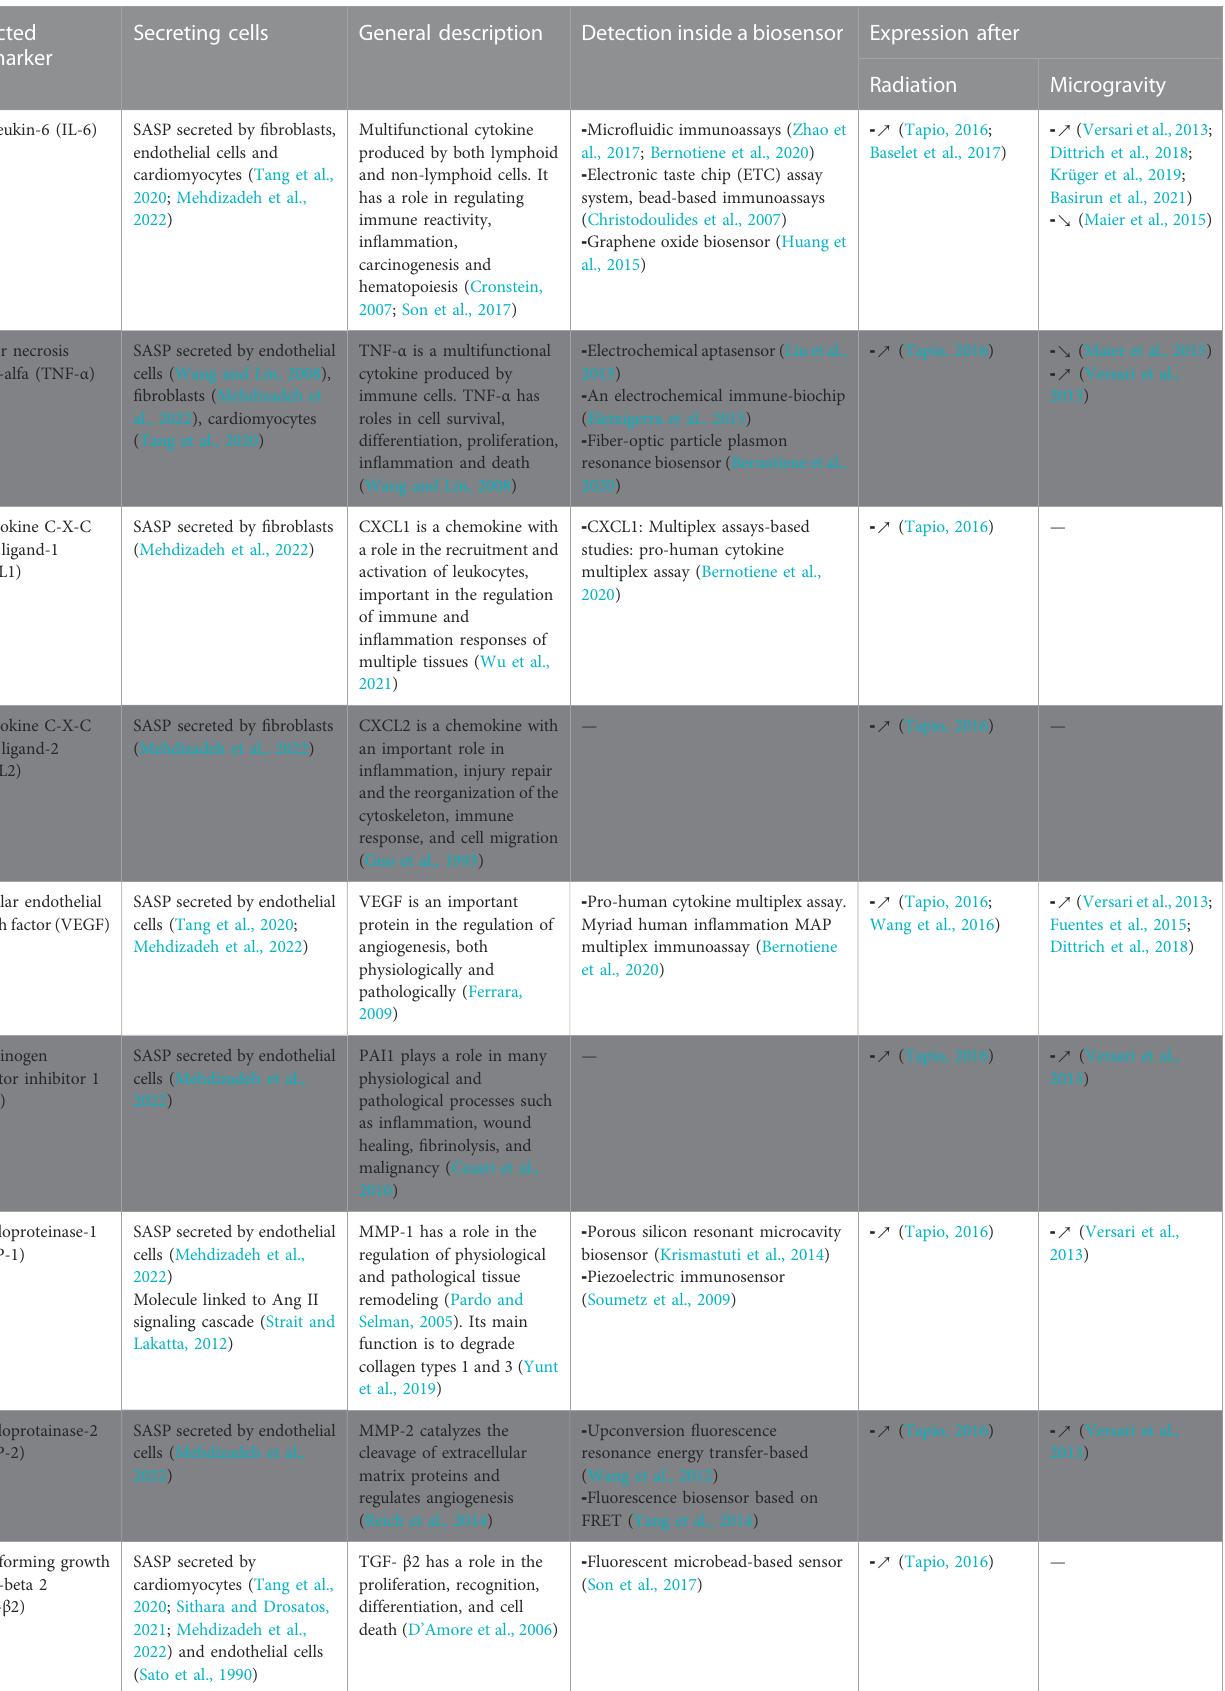
TABLE 1 Potential biomarkers to measure space-induced cardiovascular